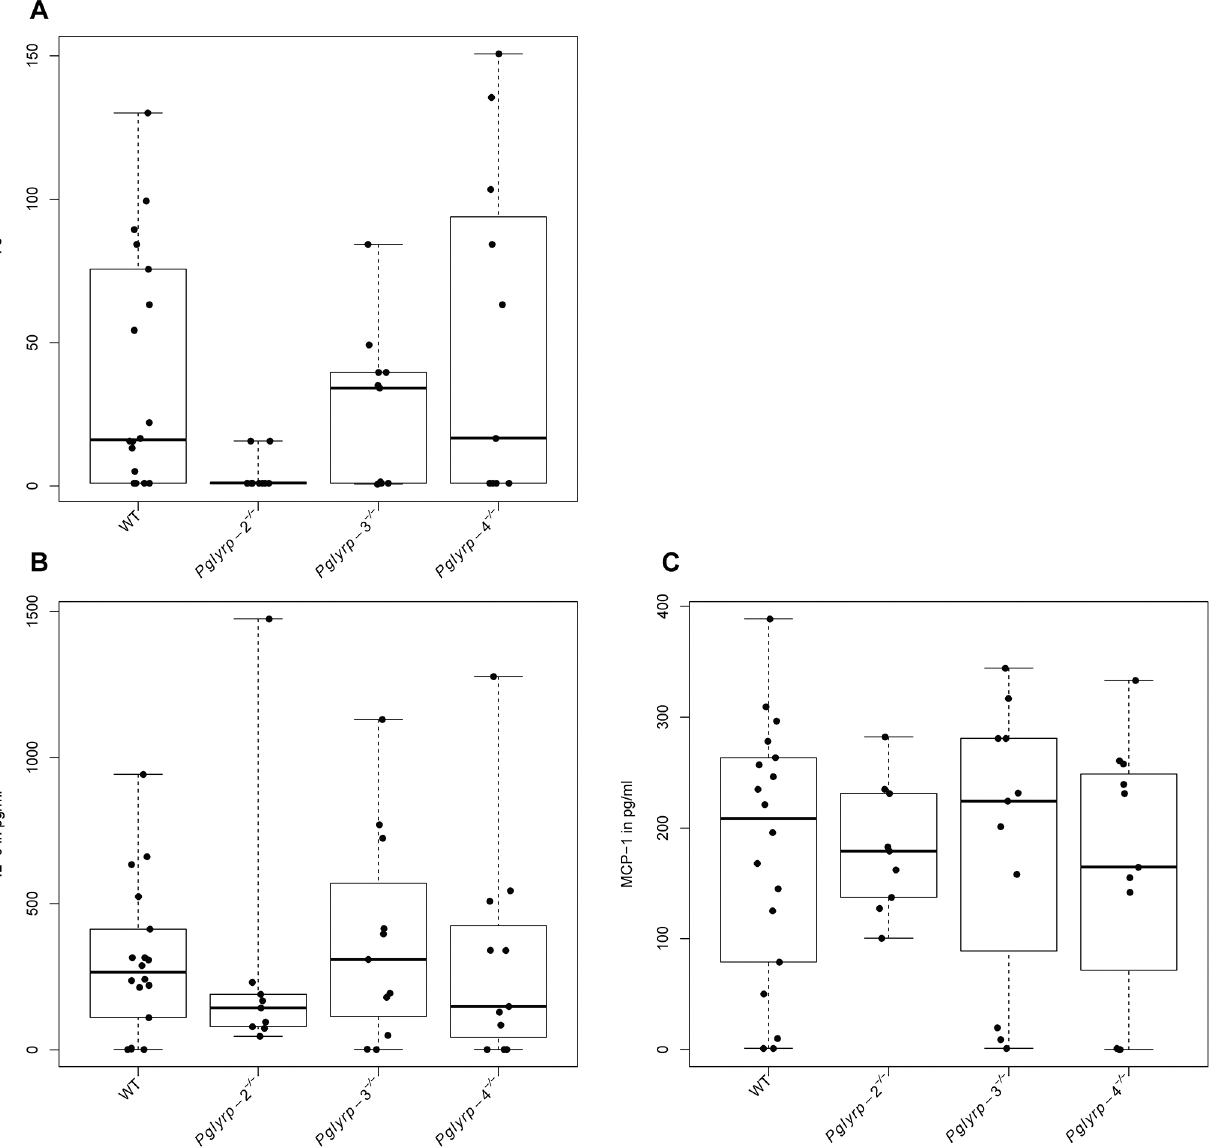
Fig 4. Lower pro-inflammatory cytokine responses in the Pglyrp -2 -/- infected eyes. Cytokines in whole eye homogenates were measured 48 h. p. i. using a cytometric bead array assay. The results show individual animals from a total of 2 – 3 trials. Induction of TNF- α was significantly lower (t = -2.4, p = 0.02) in Pglyrp -2 -/- infected eyes. Median values for MCP-1 and IL-6 were also lower in Pglyrp -2 -/- mice. Median values for all three cytokines were low in the Pglyrp -4 -/- infected eyes, but the mean values did not follow this